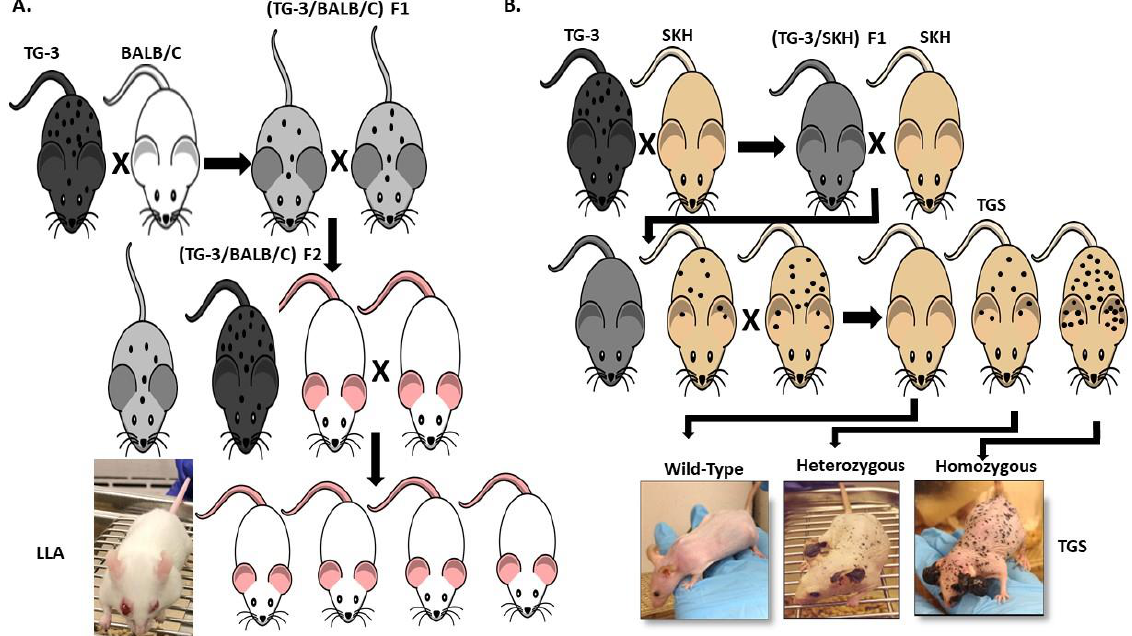
Figure 3. ( A ) Derivation of a Spontaneous Grm1 Expressing Amelanotic Melanoma Prone Mouse Model, LLA and ( B ) Hairless Spontaneous Grm1 Expressing Melanoma Prone Mouse Model, TGS.